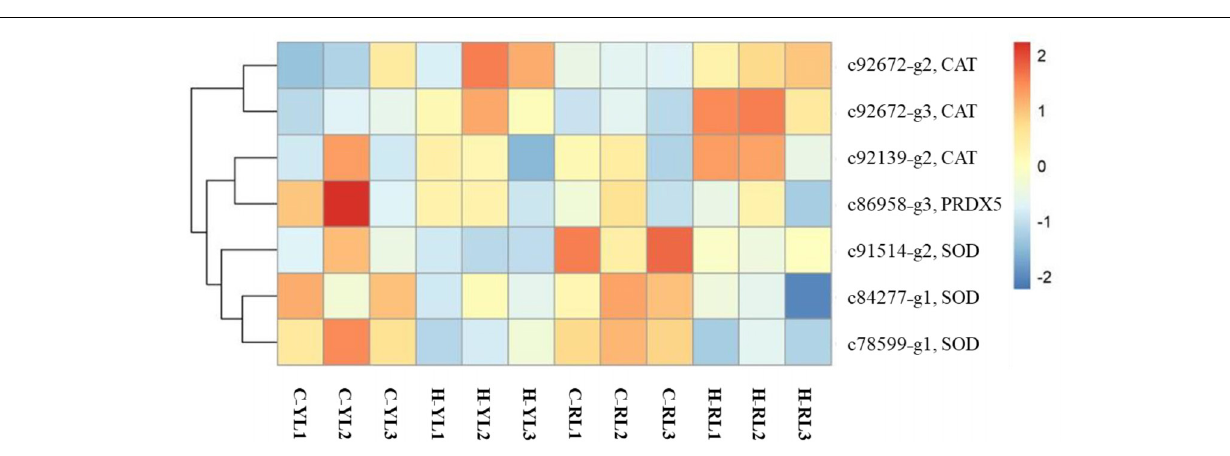
would be help to reduce the heat-damage more quickly in tolerant lines, which offered a more effective protection